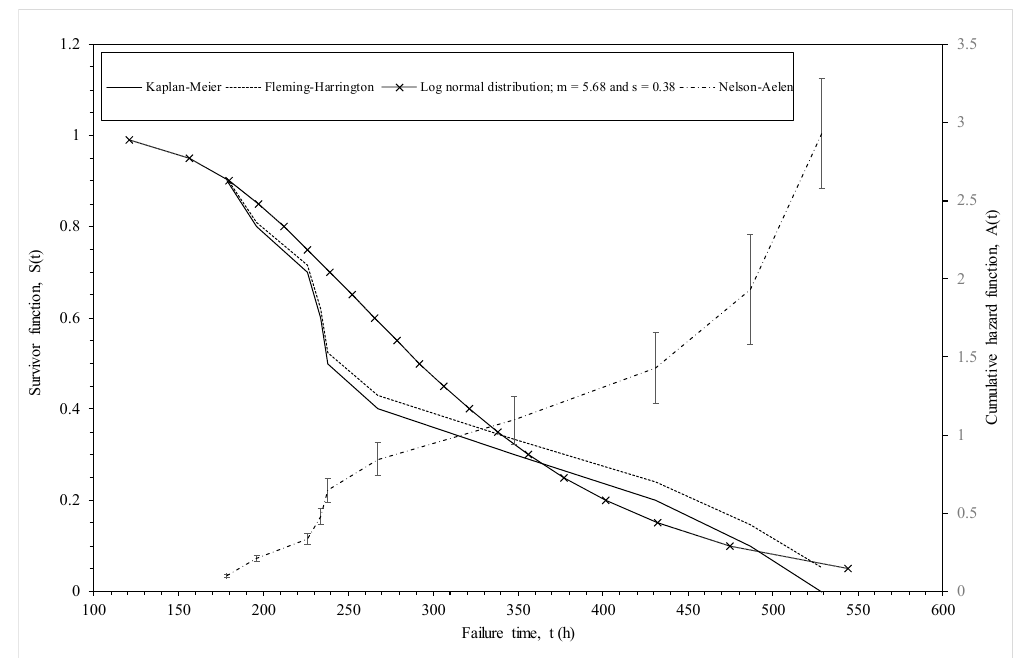
Figure 2. Various non-parametric and parametric estimates of the survivor and hazard functions for batches of 1Cr-1Mo-0.25V steel tested at 823 K and 294 MPa.